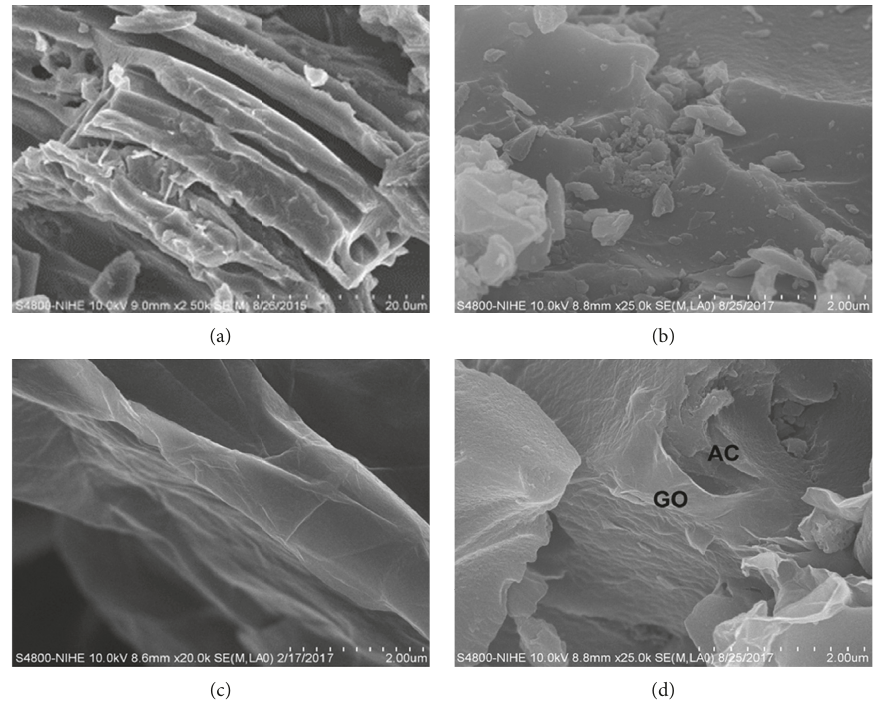
Figure 2: SEM images of sulfonated biochar (a), activated carbon (b), graphene oxide (c), and GO/AC